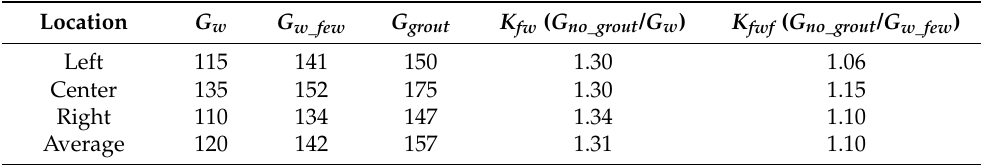
Figure 28. Gray value profiles of ( a ) left; ( b ) center; ( c ) right in Figure 27 for 200 mm thick T-shape PC girder bridge by 950 keV. Table 4. Gray values and K ratios of Figure 28 for 200 mm thick T-shape PC girder bridge by 950 keV. The grout is filled.